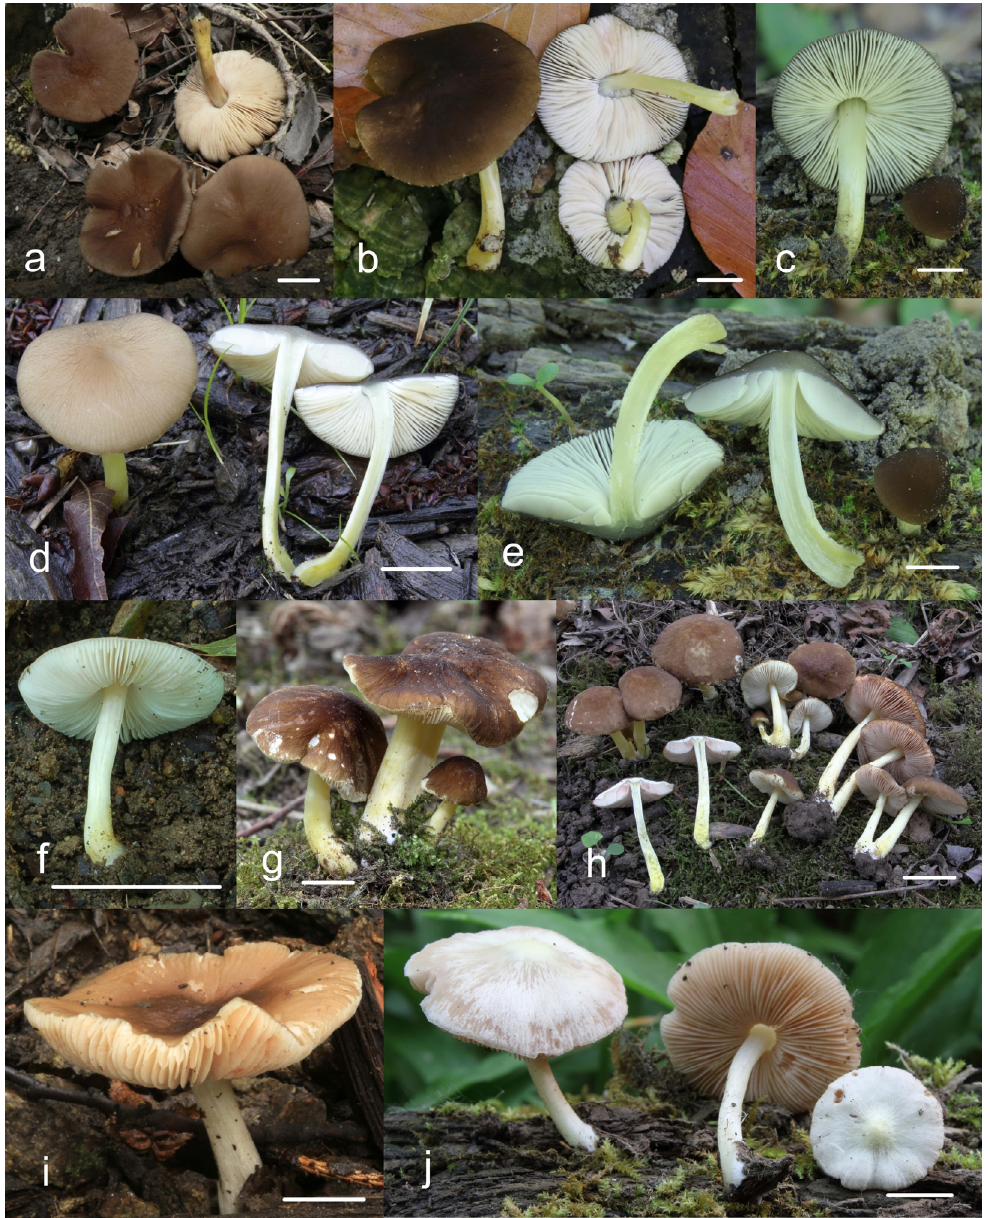
Figure 4. Pluteus romellii basidiomata in situ: ( a ). epitype BRNM 761731, ( b ). OKA-TR1445, ( c , e ). FG27052020, ( d ). FG24052020, ( f ). NBM-F-009322, ( g , h ). FG 14042019017, ( i ). BRNM 781260, ( j ). Pluteus romellii f. albidus FG 25042018003. Scale bars 1 cm.